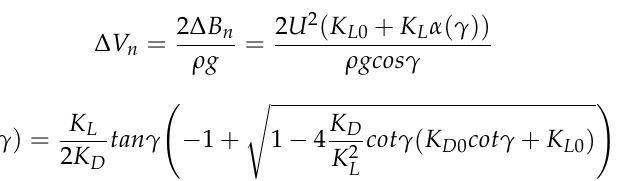
Figure 14. The underwater glider integrated optimized pressure